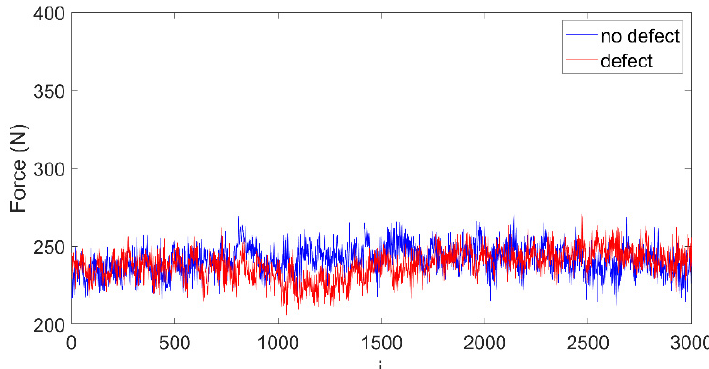
Figure 8. Cutting forces measured during drilling of GFRP without defect (blue line) and with defect (red line).